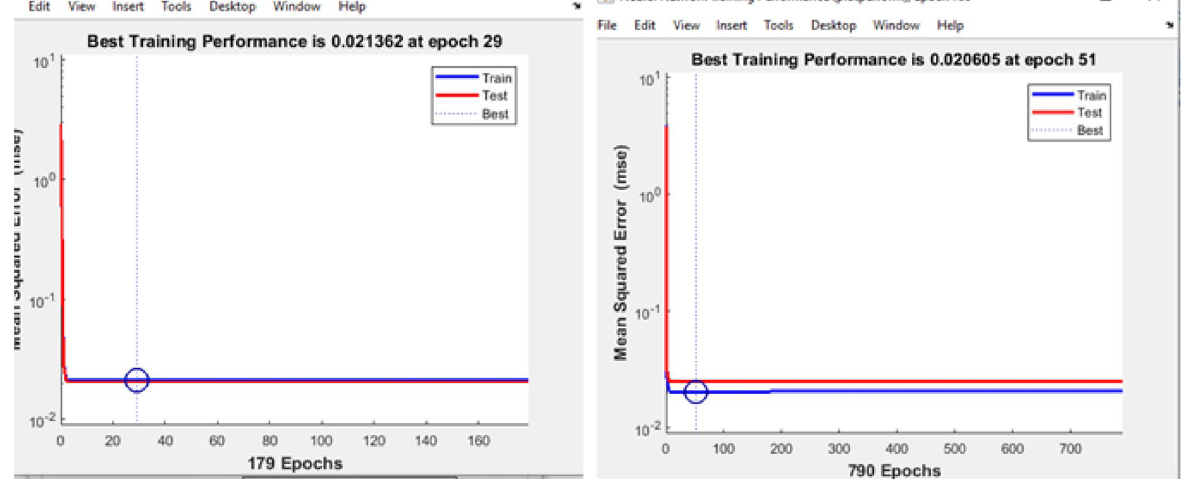
Fig. 8 Performance measure of Pseudo-Predictive Deep denoising network